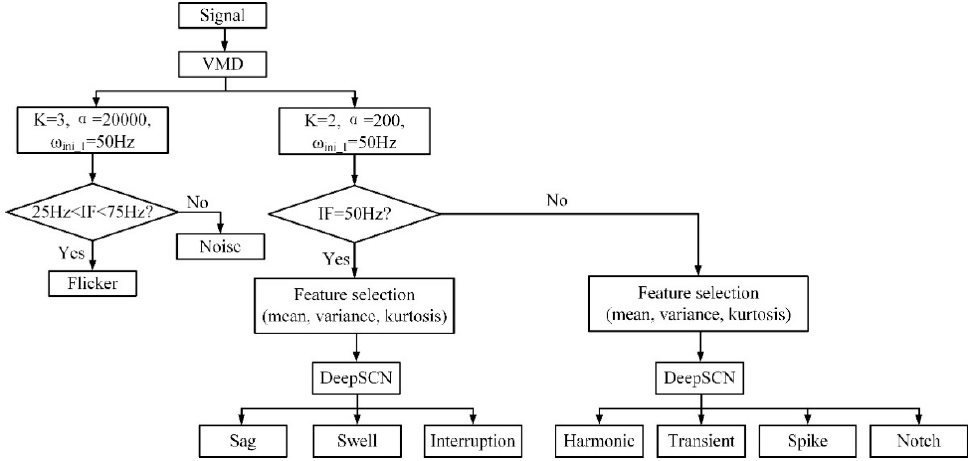
Figure 7. The flowchart of the proposed power quality disturbance (PQD) detection and classification method.